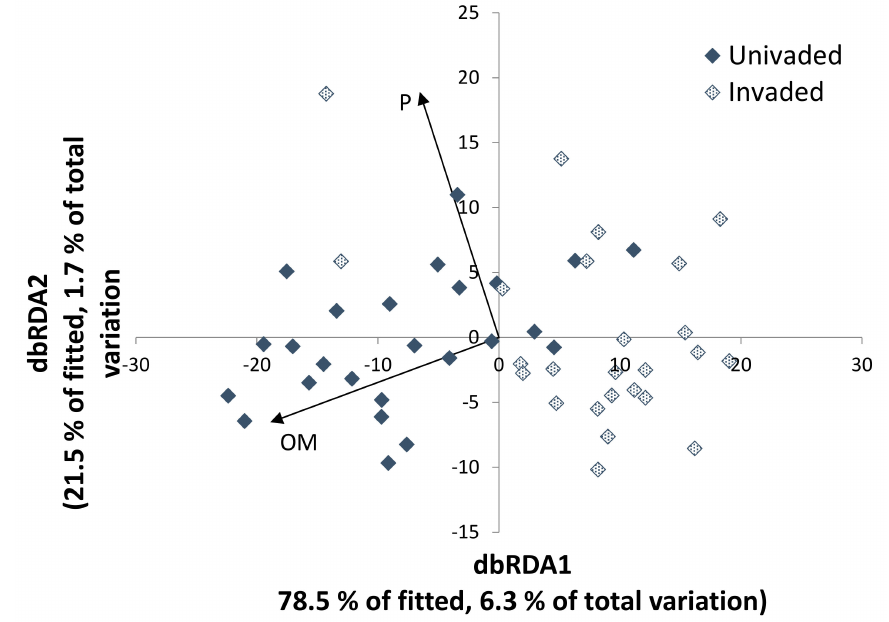
Figure 5. Plot relating fungal populations to soil parameters di ff erentiating uninvaded and invaded sites. Of the parameters measured, only percentage total phosphorous and organic matter showed a significant correlation with fungal community composition ( p < 0.01, n = 25 per site). dbRDA: distance-based redundancy analysis.